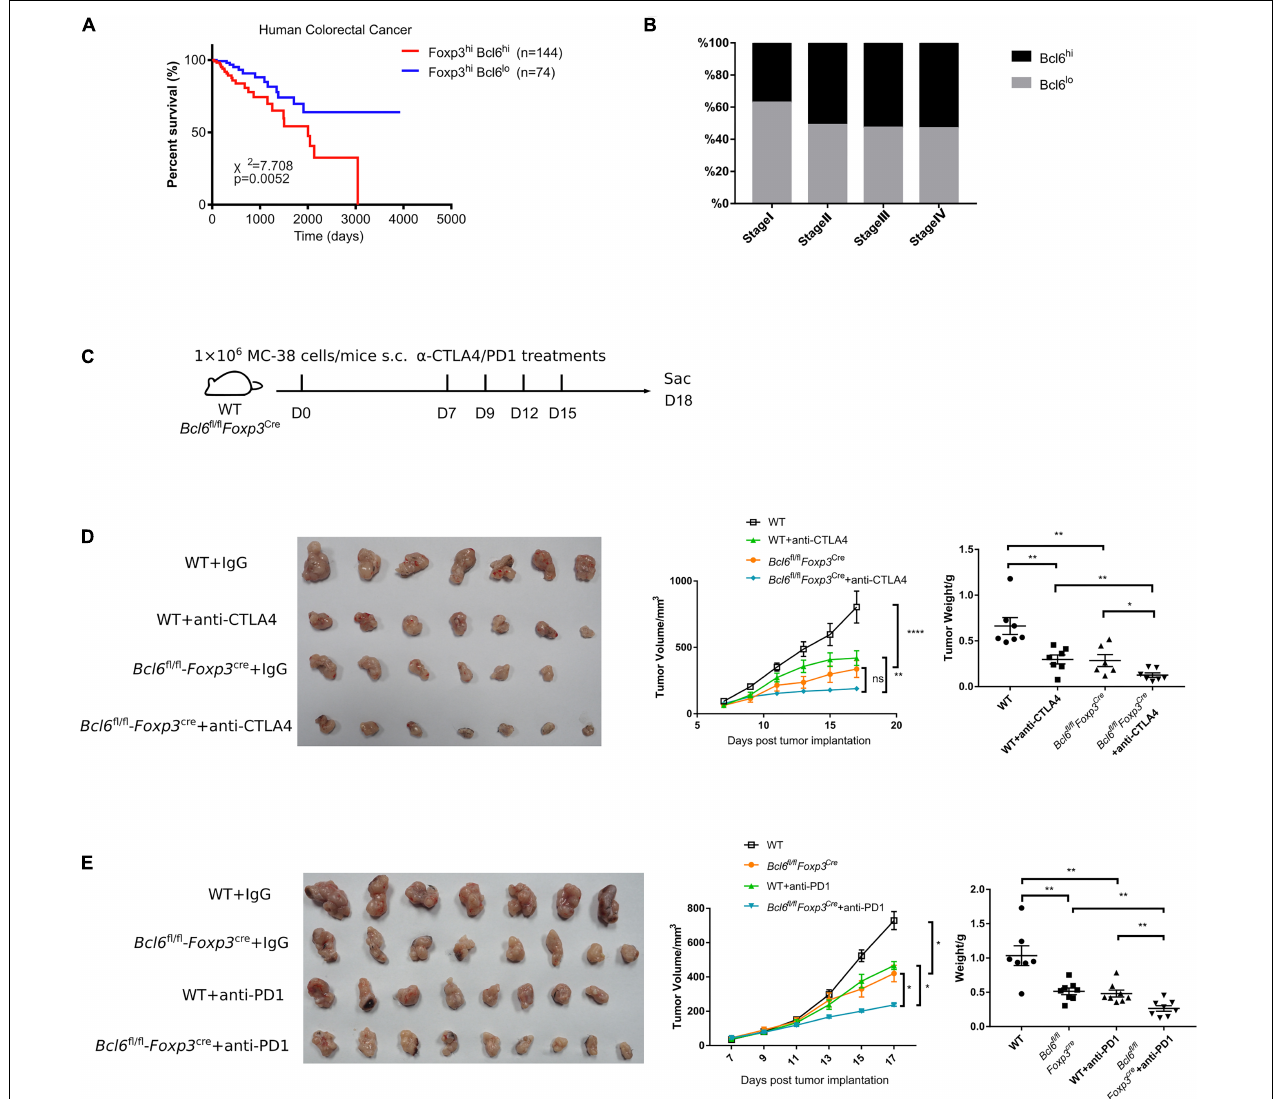
FIGURE 5 | Bcl6 expression in Treg cells may predict the prognosis of human colorectal cancer. (A) Survival curves of Bcl6 hi Foxp3 hi and Bcl6 lo Foxp3 hi patients in human colorectal cancer TCGA dataset. (B) Proportion of Bcl6 hi Foxp3 hi and Bcl6 lo Foxp3 hi patients among Foxp3 hi patients in different stages of human colorectal cancer. (C) Set up of anti-CTLA4/anti-PD1 checkpoint blockade therapy. Bcl6 fl / fl Foxp3 Cre and WT mice were implanted with MC-38 cells subcutaneously on day 0 and treated with anti-CTLA4 or anti-PD1 antibody at day 7, 9, 12, and 15. (D,E) Pictures of tumor samples harvested at day 18 after tumor implantation, with tumor weight and growth curve. Mice received either anti-CTLA4 (D) or anti-PD1 (E) therapy. The data were collected from 8 to 14 mice per group of two independent experiments. Statistical differences were calculated by unpaired t -test (tumor weight) or two-way ANOVA with a post hoc Turkey test (tumor growth curve). * p < 0.05, ** p < 0.01, **** p < 0.0001, ns, no significance. Data are presented as mean ± SEM. See also Supplementary Figure 2